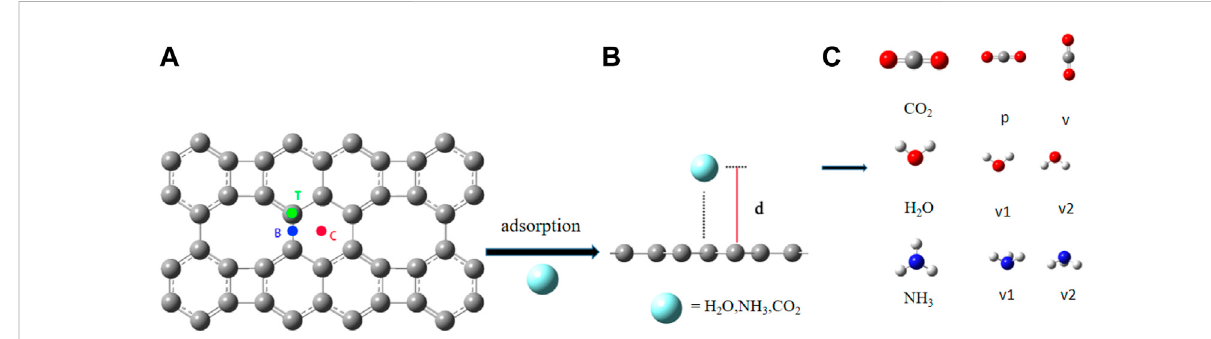
FIGURE 1 (A) Three adsorption sites on the graphene-like surface; (B) The scheme of adsorption of a molecule on the surface; (C) The adsorption con fi gurations of H 2 O, NH 3 and CO 2 .